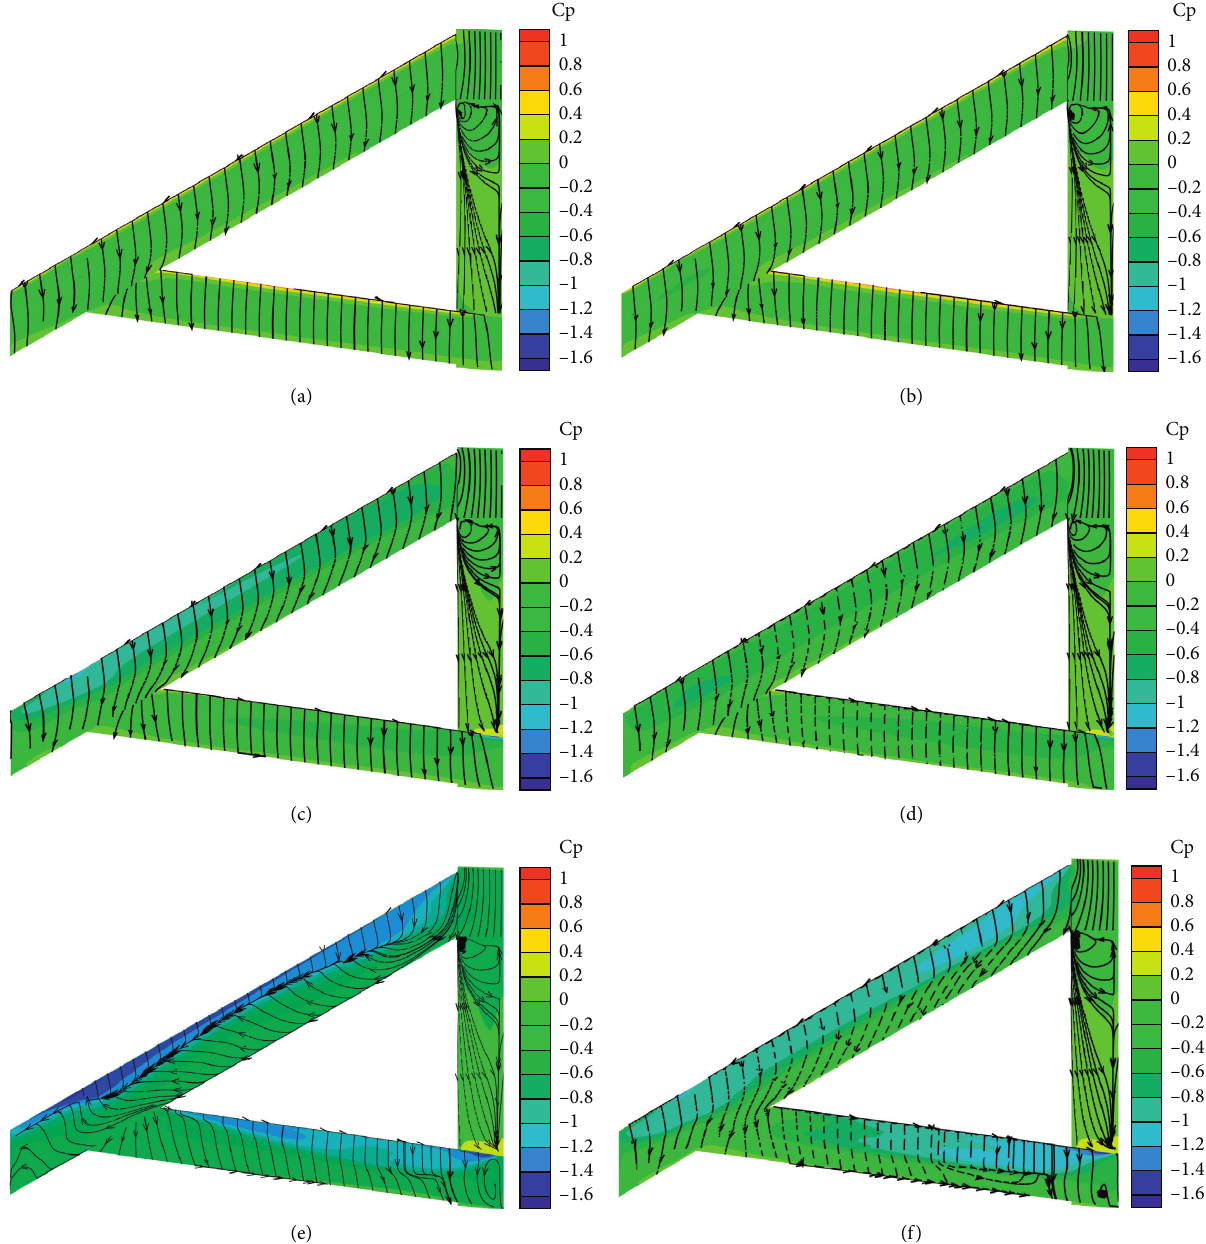
Figure 8: Effects of static aeroelasticity on wing surface pressure. (a) Rigid wing ( α � − 4 ° ). (b) Flexible wing ( α �− 4 ° ). (c) Rigid wing ( α � 0 ° ). (d) Flexible wing ( α � 0 ° ). (e) Rigid wing ( α � 4 ° ). (f) Flexible wing ( α � 4 °